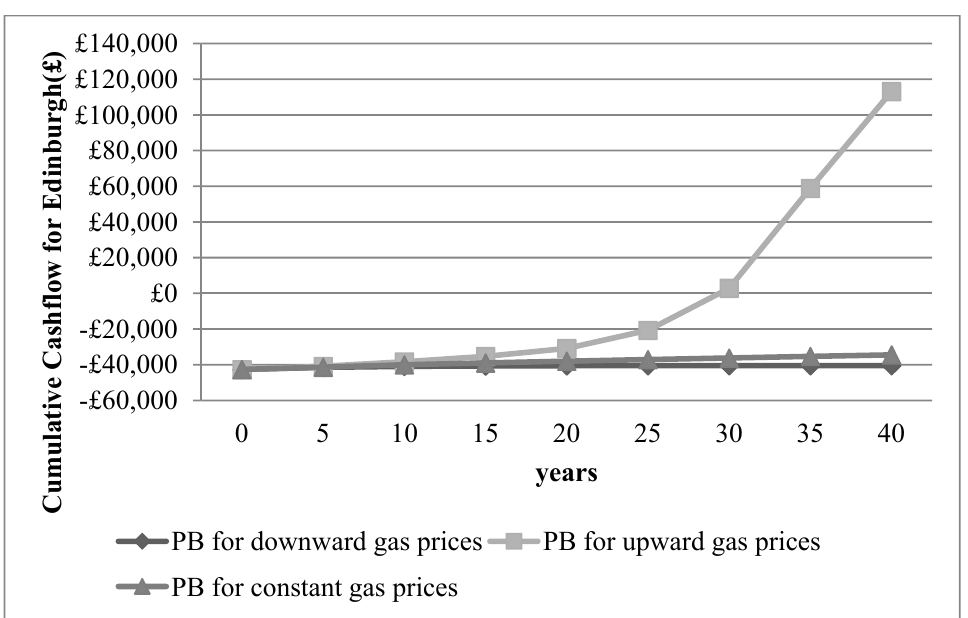
Figure 21. Cumulative cash flow of the refurbished house for current and future Edinburgh weather data over 40 years for different gas price trends.